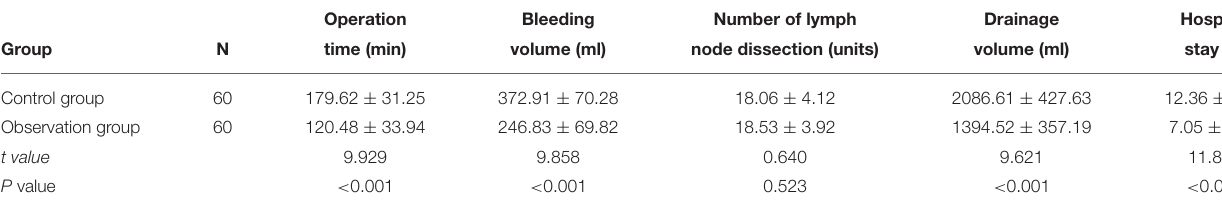
TABLE 2 | Comparison of surgical indexes between the two groups ( n , x ±